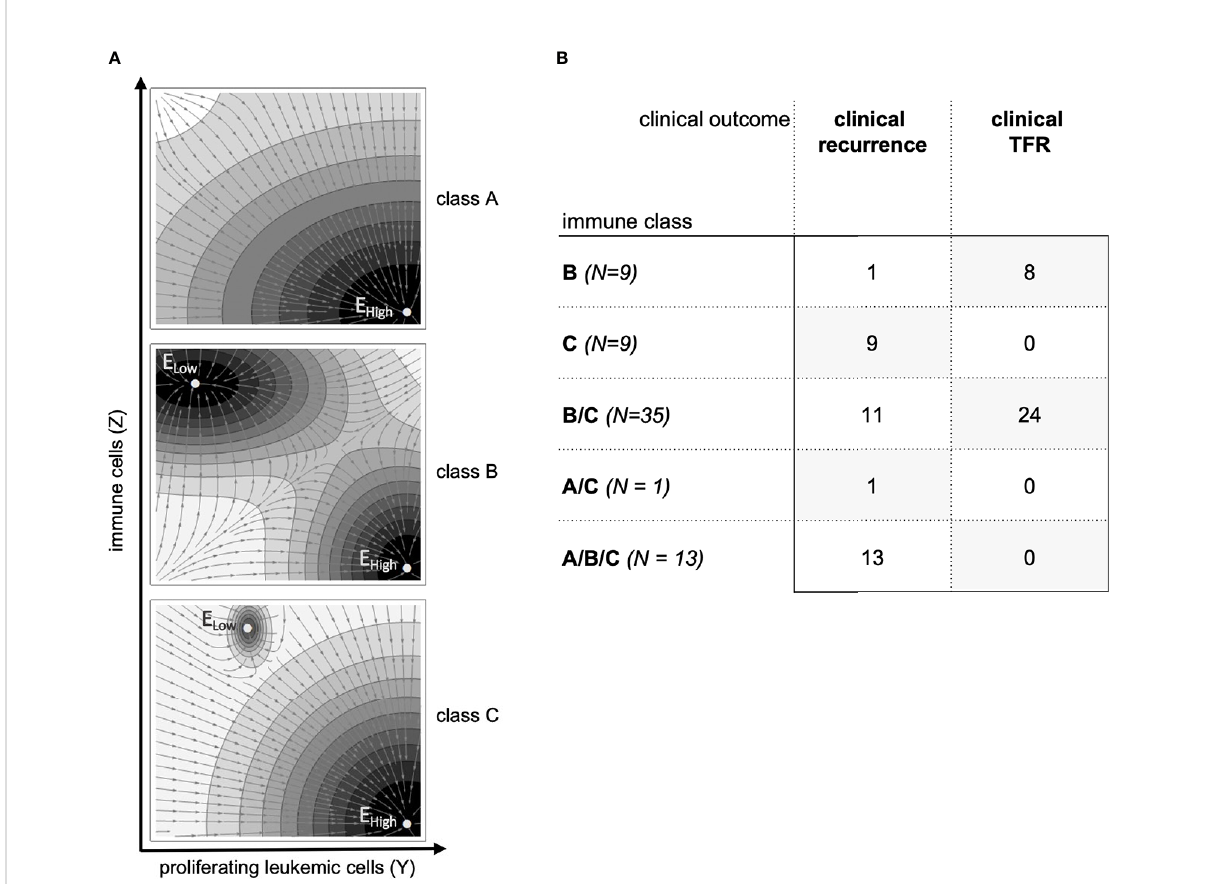
FIGURE 3 (A) Sketch of the prototypical immunological landscape classes A, B and C (see Supplementary Text S6). The phase space is spanned by the number of proliferating leukemic cells Y on the x-axis and the number of immune cells Z on the y-axis. Steady states of the dynamical system are identi fi ed by E High and E Low (see Supplementary Text S6). The vector fi eld indicates the direction of model trajectories after TKI cessation and the basin of attractions of the stable steady states. (B) Classi fi cation of the 67 patients according to immune classes and their clinical outcomes after treatment